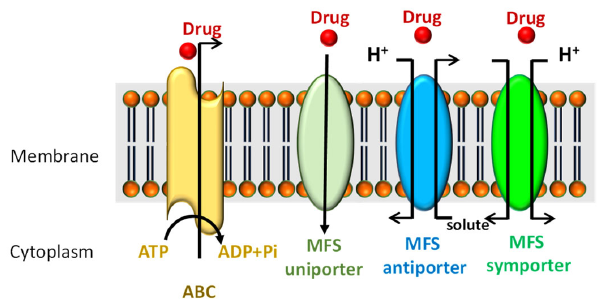
Figure 4. ABC and MFS transporters. ABC: ATP-binding cassette transporter superfamily, MFS: major facilitator superfamily.